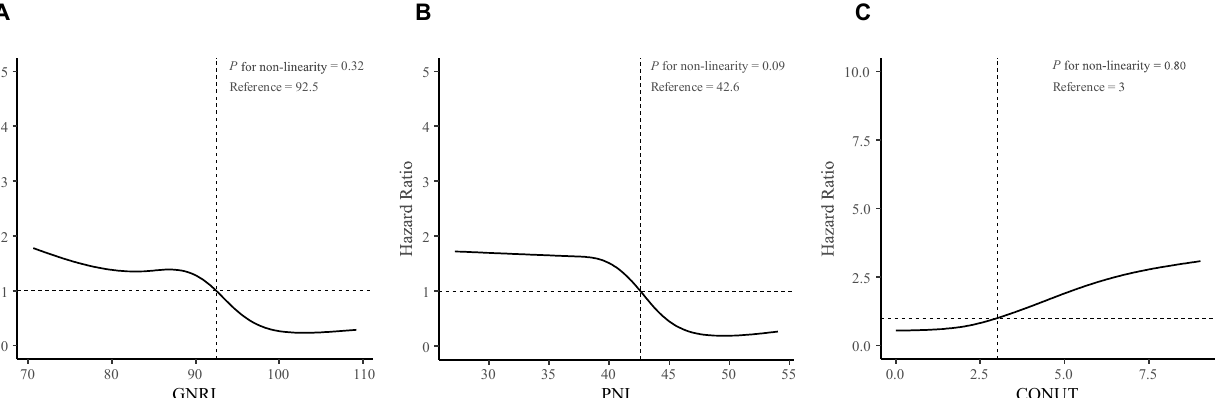
Figure 2. Restricted Cubic Spline analyses for testing non-linearity associations. ( A ) GNRI; ( B ) PNI; ( C ) CONUT. The RCS analyses were adjusted for age (continuous), sex (female or male), tumor progression before RN (with or without); lower cranial nerves injury (with or without), bilateral necrosis (with or without), necrosis involving ≥ 2 brain regions (with or without), and history of stroke (with or without). The solid lines represent the hazard ratios, and the gray zones represent the 95% confidence interval. Abbreviations: RN, Radiation-induced brain necrosis; GNRI, Geriatric Nutritional Risk Index; PNI, Prognostic Nutritional Index; CONUT, Controlling Nutritional Status.